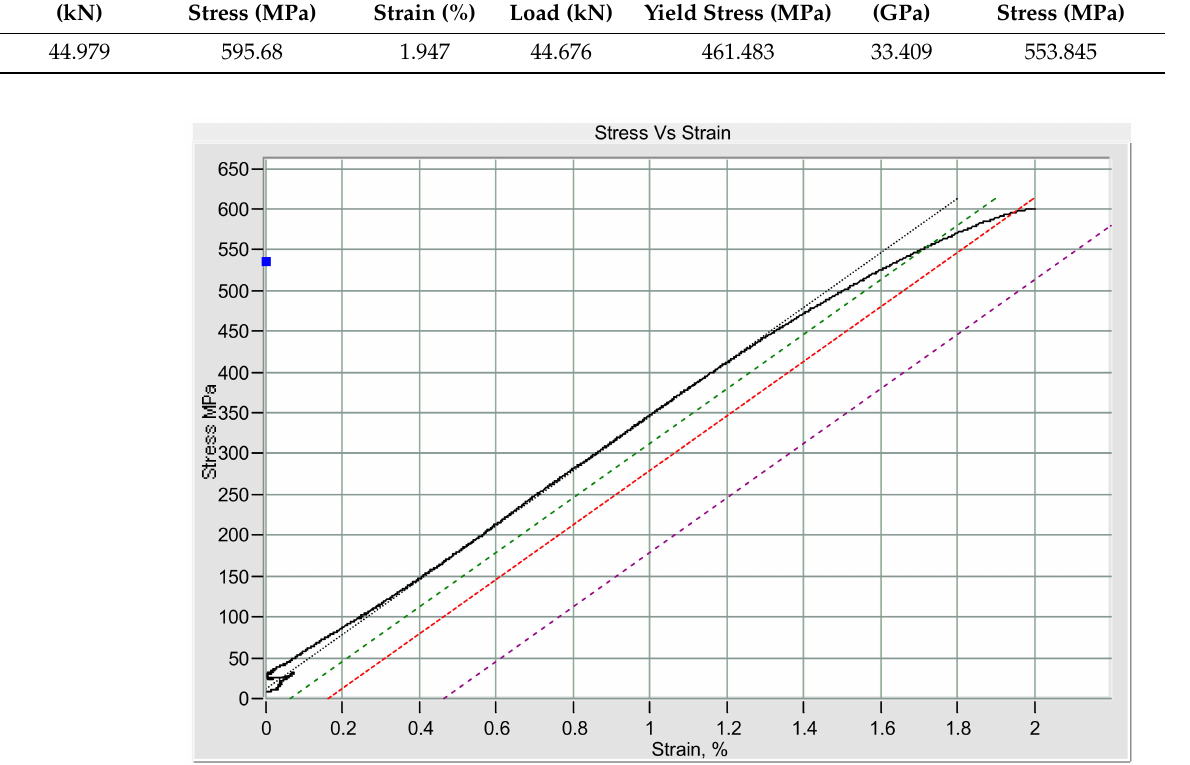
Figure 9. Stress and strain relationships of the samples obtained by the confirmation